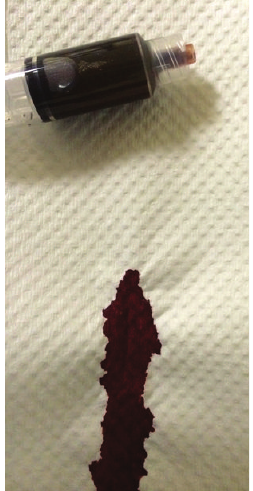
Figure 2: Chocolate-brown